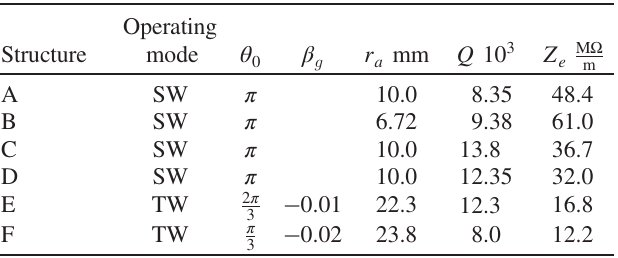
TABLE I. Main parameters of the example structures; θ ¼ phase advance, β group velocity for traveling wave 0 g ¼ minimal aperture radius, Q ¼ unloaded quality operation, r a ¼ shunt impedance. factor, Z e